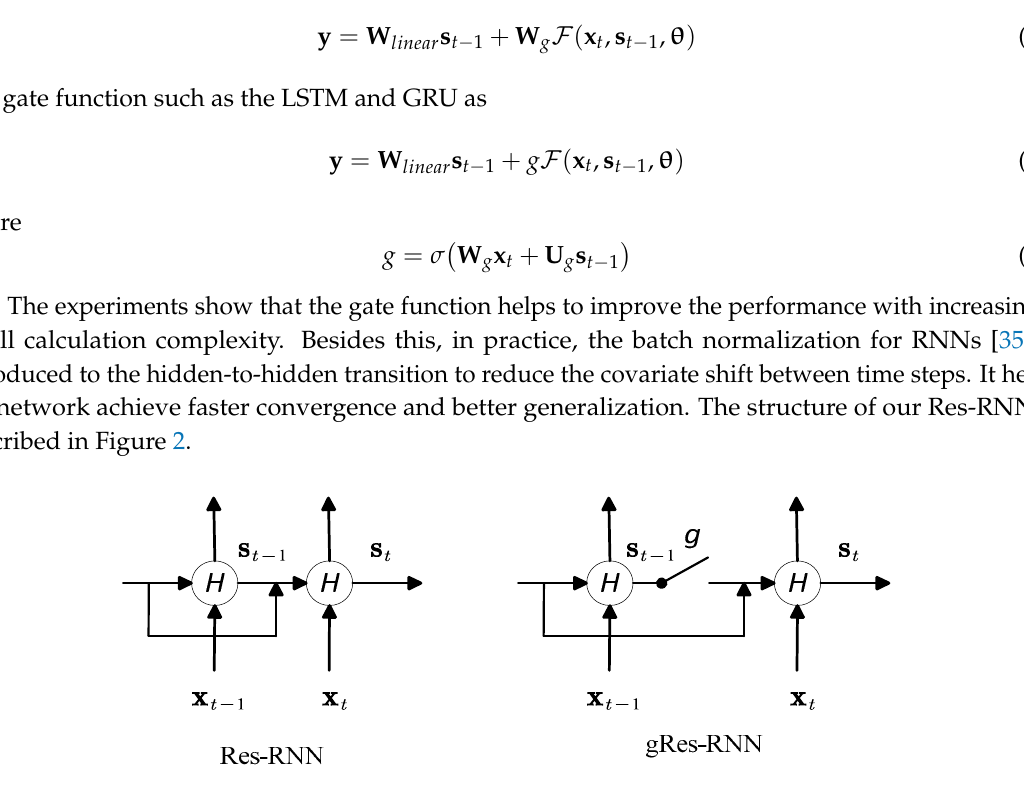
Figure 2. The structure of Res-RNN and gRes-RNN.